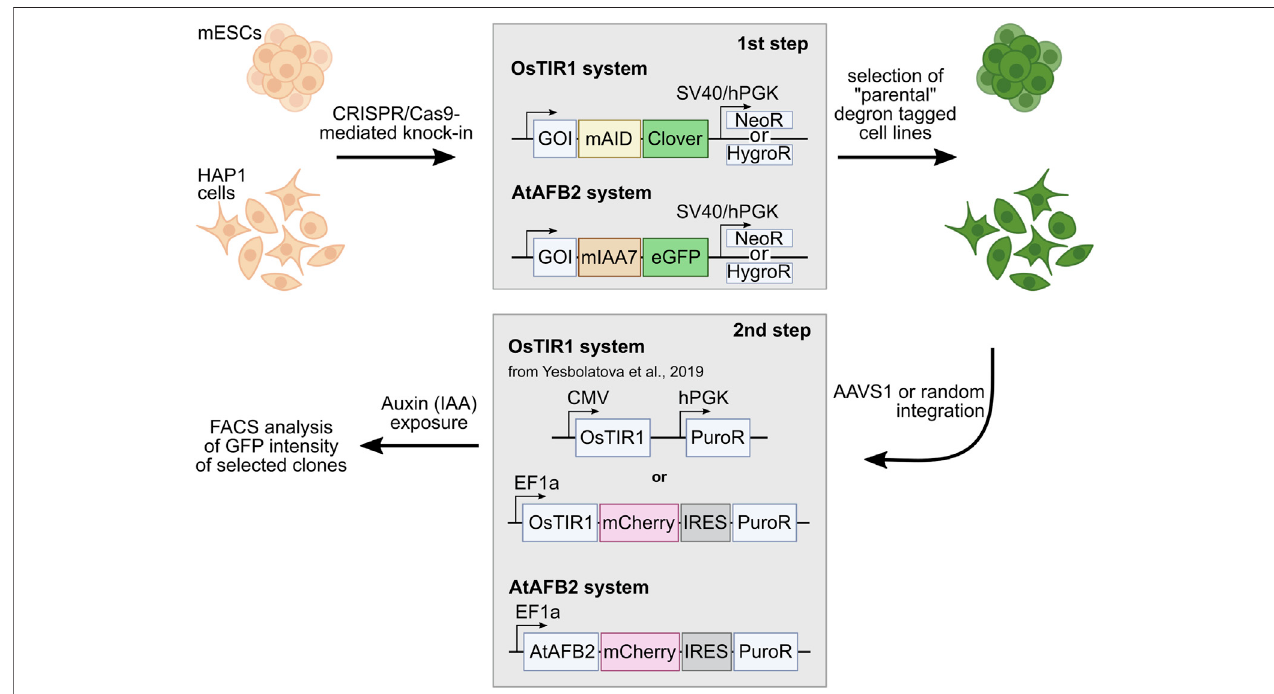
FIGURE 1 | Outline of the AID experiments performed with two AID systems: OsTIR1 and AtAFB2. The fi rst step includes targeted integration of the AID tags and NeoR / HygroR selection cassette. In the second step, selected degron-tagged clones are transformed with AFB expression plasmids with the Puro R selection cassette. GOI, gene of